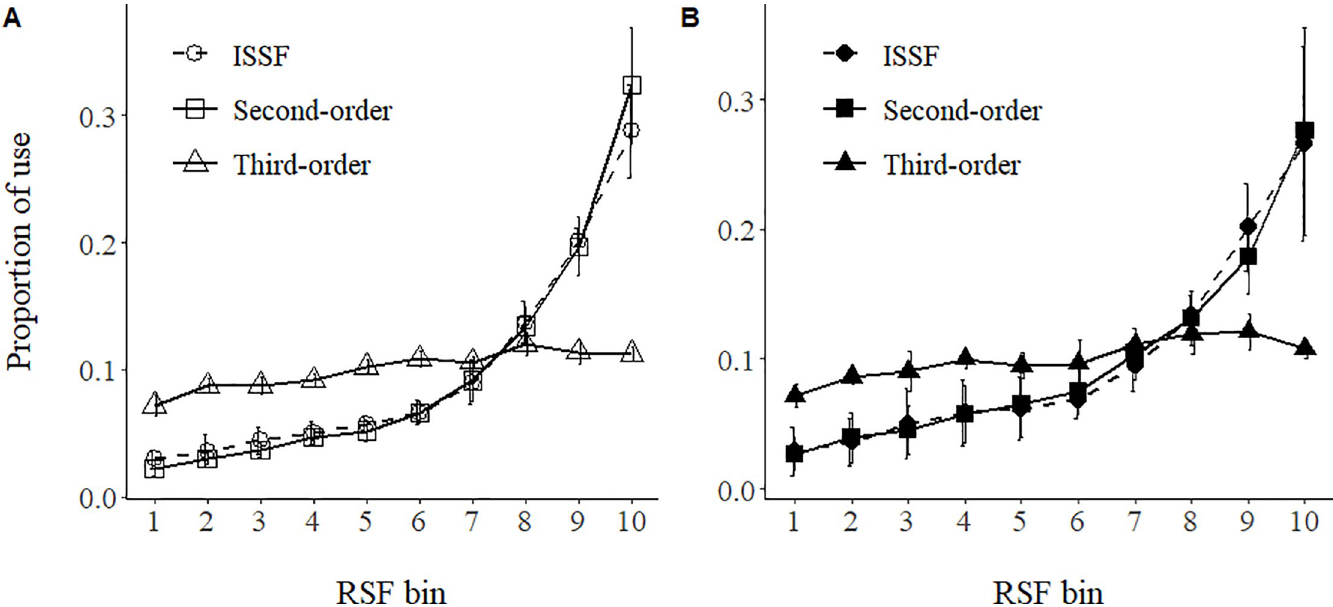
Fig 3. Pronghorn predicted relative probabilities of occurrence within ten ordinal habitat categories binned by resource selection probability functions during spring (A) and fall (B) for second-, third-, and scale-integrated step selection function (ISSF) spatial maps. Using k -fold cross validation, maps indicate that second-order models and ISSF scale maps during both seasons were more effective in discriminating between low versus high quality (bins 8–10) migration habitat than third-order models.